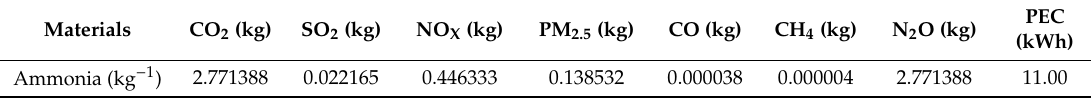
Table 16. PEC and pollution emissions from the manufacture of